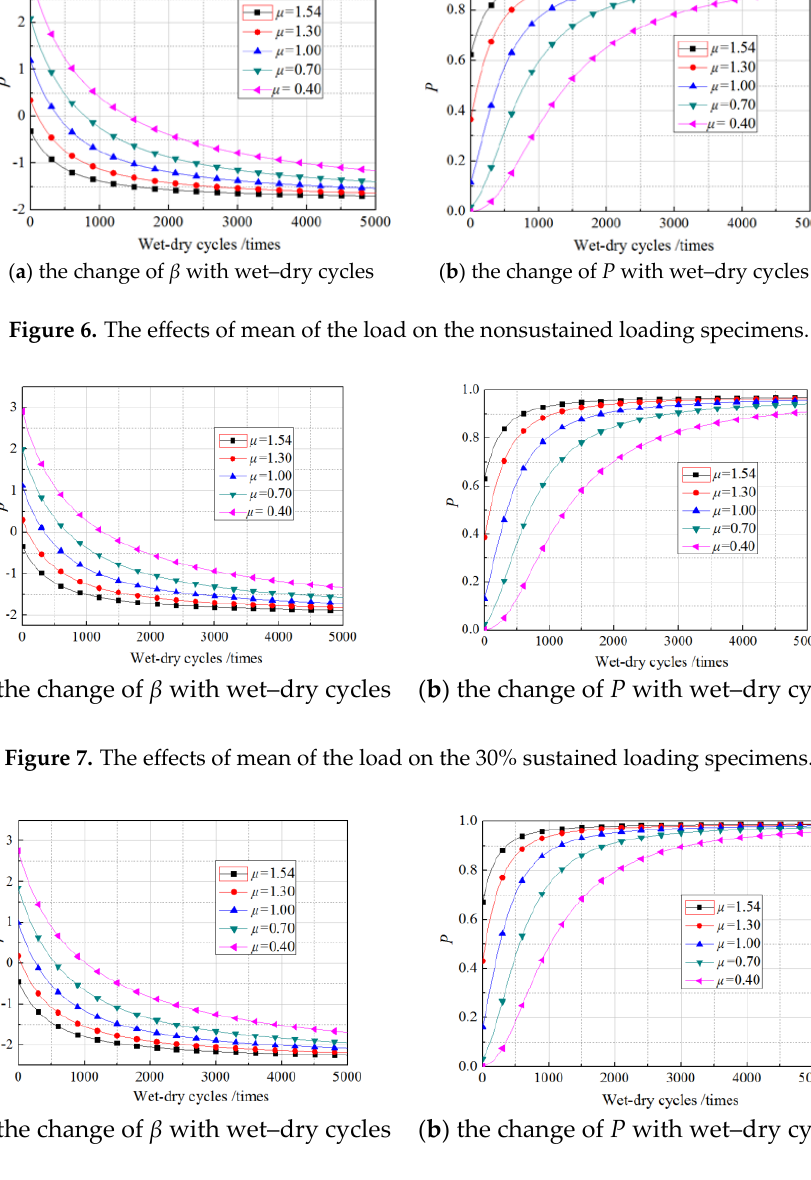
Figure 8. The effects of mean of the load on the 60% sustained loading specimens.